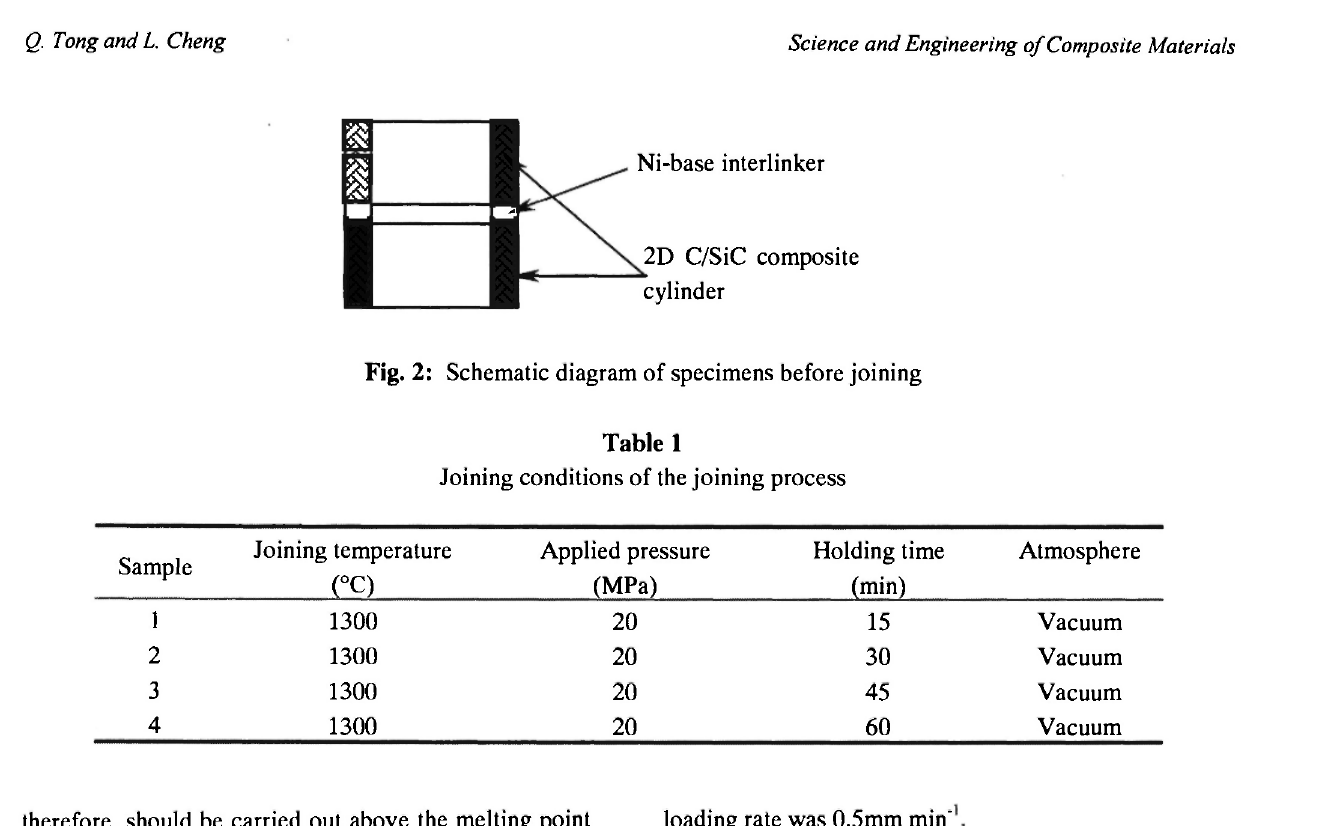
Fig. 2: Schematic diagram of specimens before joining